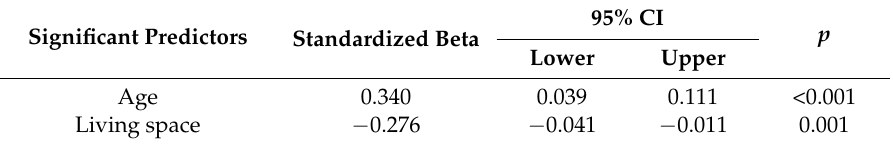
Table 4. Multiple linear regression analysis of factors associated with EHF scores in leprosy-affected study